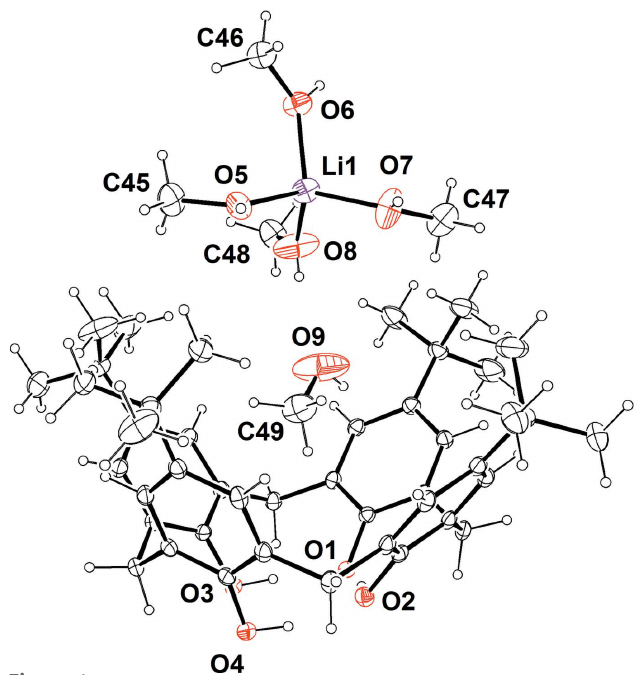
Figure 1 ORTEP diagram of the Li complex of p - tert -butylcalix[4]arene with displacement ellipsoids at the 20% probability level.